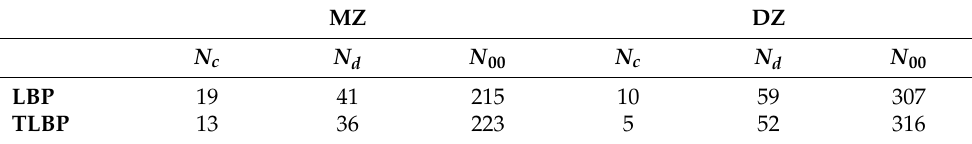
Table 3. Numbers of concordant and discordant MZ and DZ twin pairs for LBP